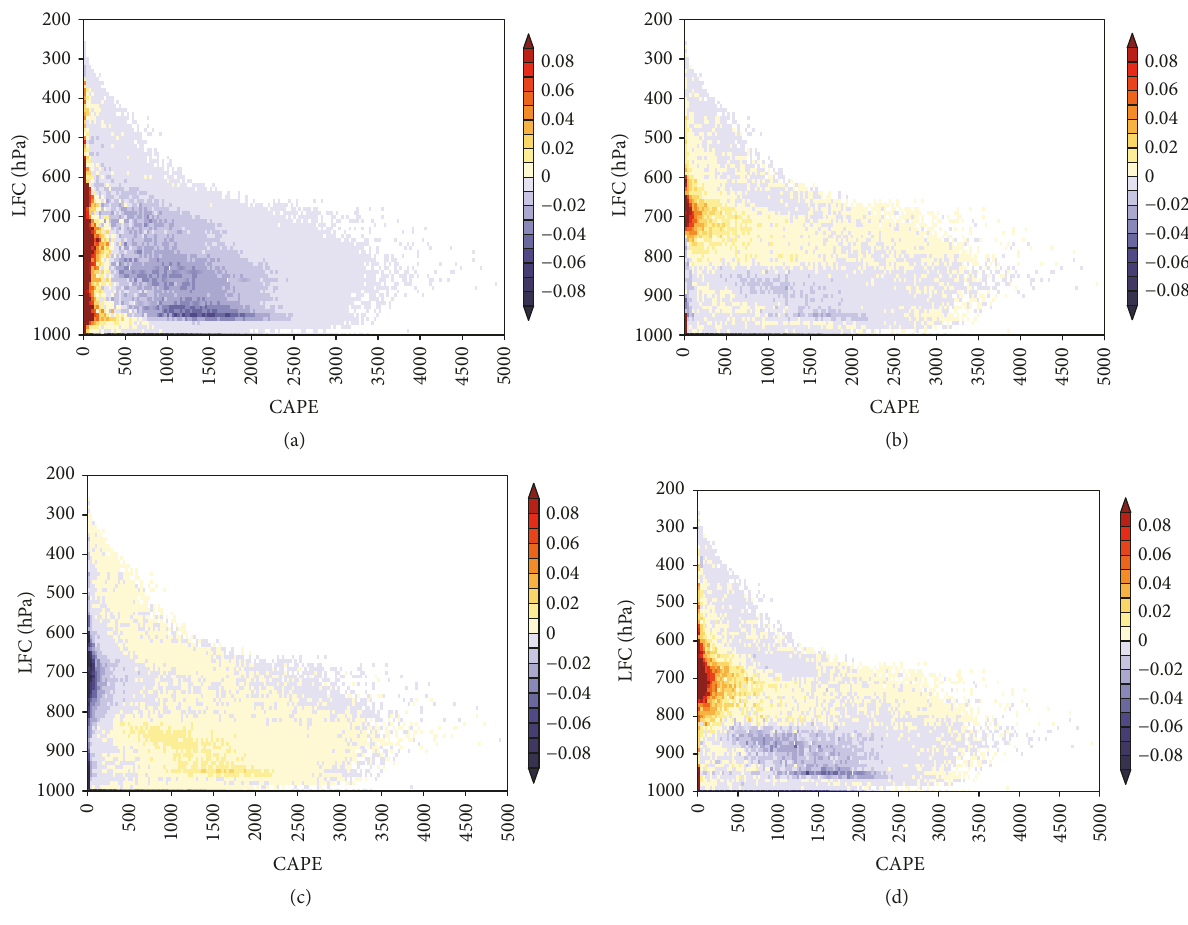
Figure 2: The same as Figure 1 except for CAPE and